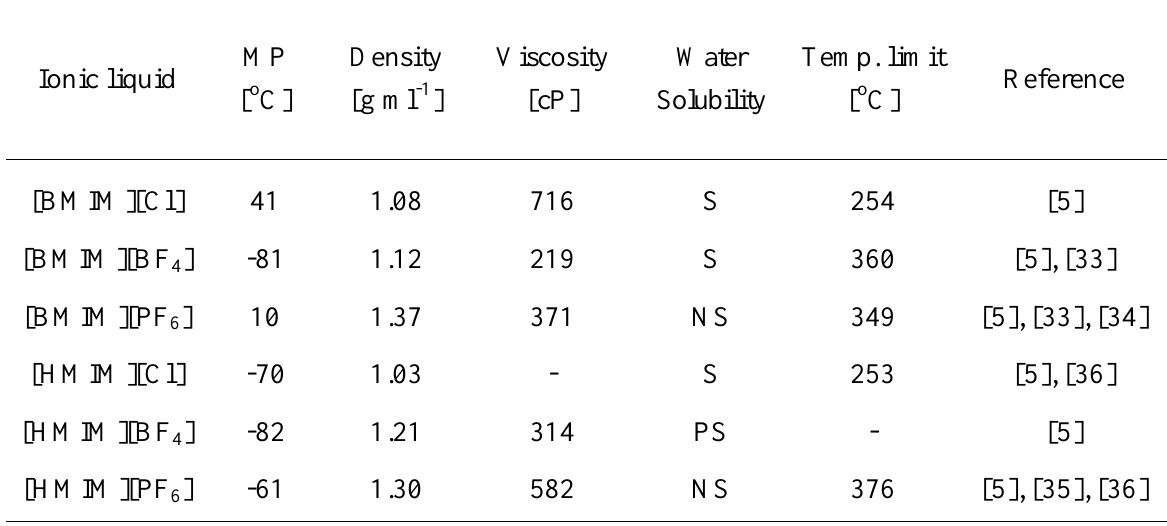
Table 2. Selected properties of 1-butyl- and 1-hexyl-3-methylimidazolium